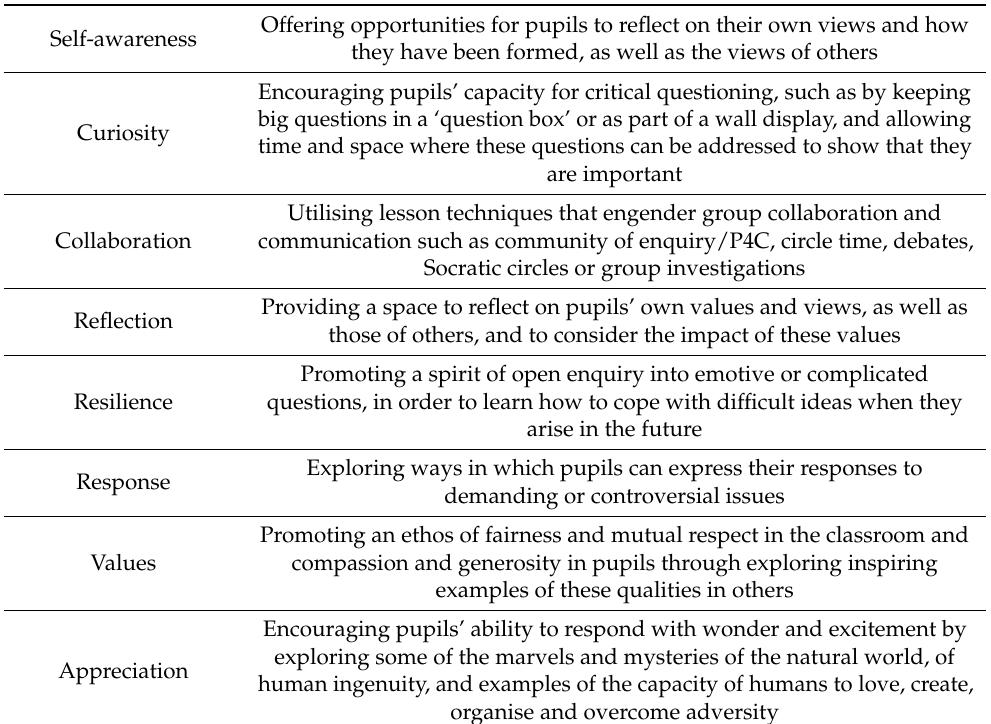
Table 1. Key elements for promoting spirituality through religious education. Taken from: